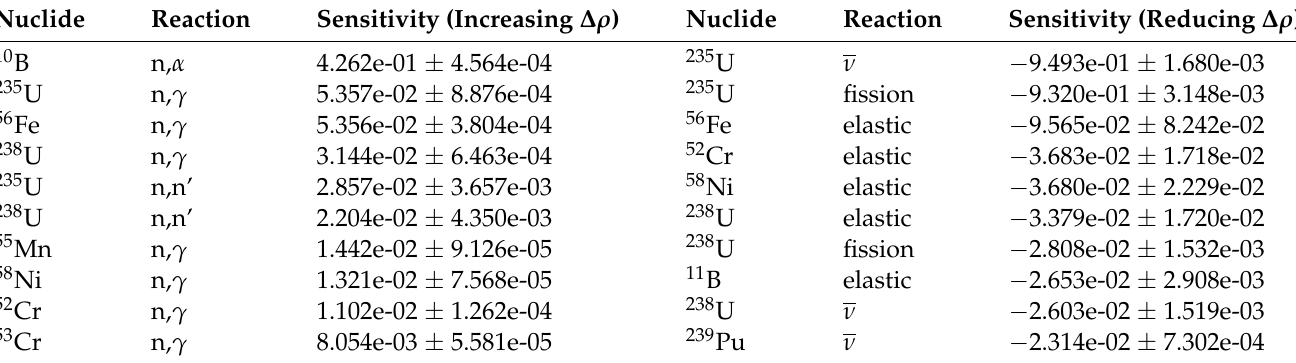
Table 6. EBR-II: top control rod worth sensitivities (reactivity difference between all controls fully inserted and all controls fully withdrawn *, ∆ ρ = 4728 ± 25 pcm; top 10 positive and top 10 negative mixture-, region- and energy-integrated sensitivities, determined with TSUNAMI-CE using ENDF/B-VII.1 data).